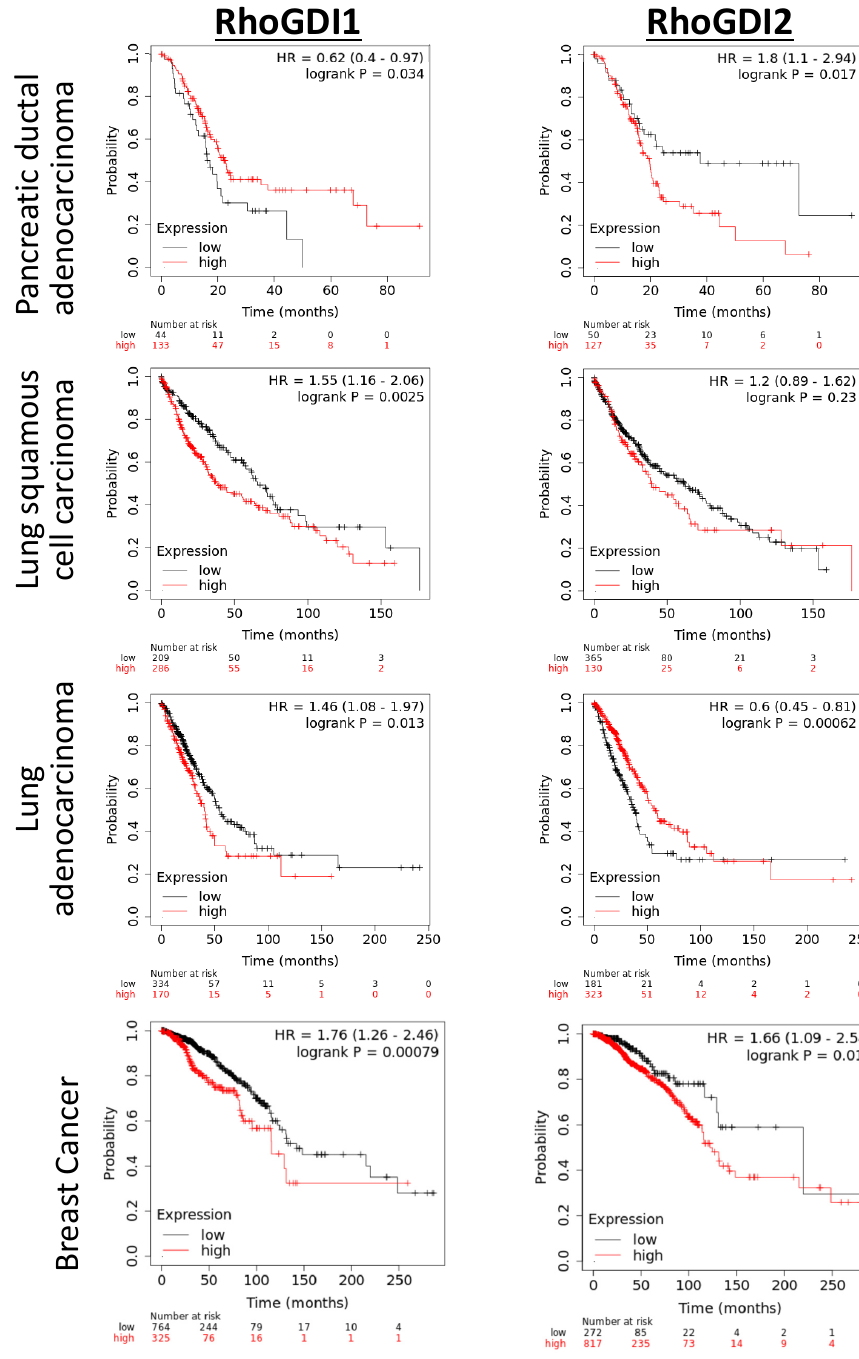
Figure 5. Correlation between patient survival and expression of RhoGDI1 and RhoGDI2 in few cancers. The Kaplan–Meier plotter (https://kmplot.com (accessed on 25 January 2023)) can be used to establish a correlation between the survival of patients and the level of expression of any gene in the primary tumour. Sources for the database include GEO, TCGA and EGA. The plots shown here were chosen to highlight the duality of RhoGDI2 expression in cancer that has either a good or poor prognosis, sometimes for cancer affecting the same organ (compare the curves for lung squamous cell carcinoma and lung adenocarcinoma). It also illustrates that the expression of RhoGDI2 and RhoGDI1 do not always correlate similarly to survival, as seen for pancreatic ductal adenocarcinoma, showing that they do not fulfill exactly the same function during cancer